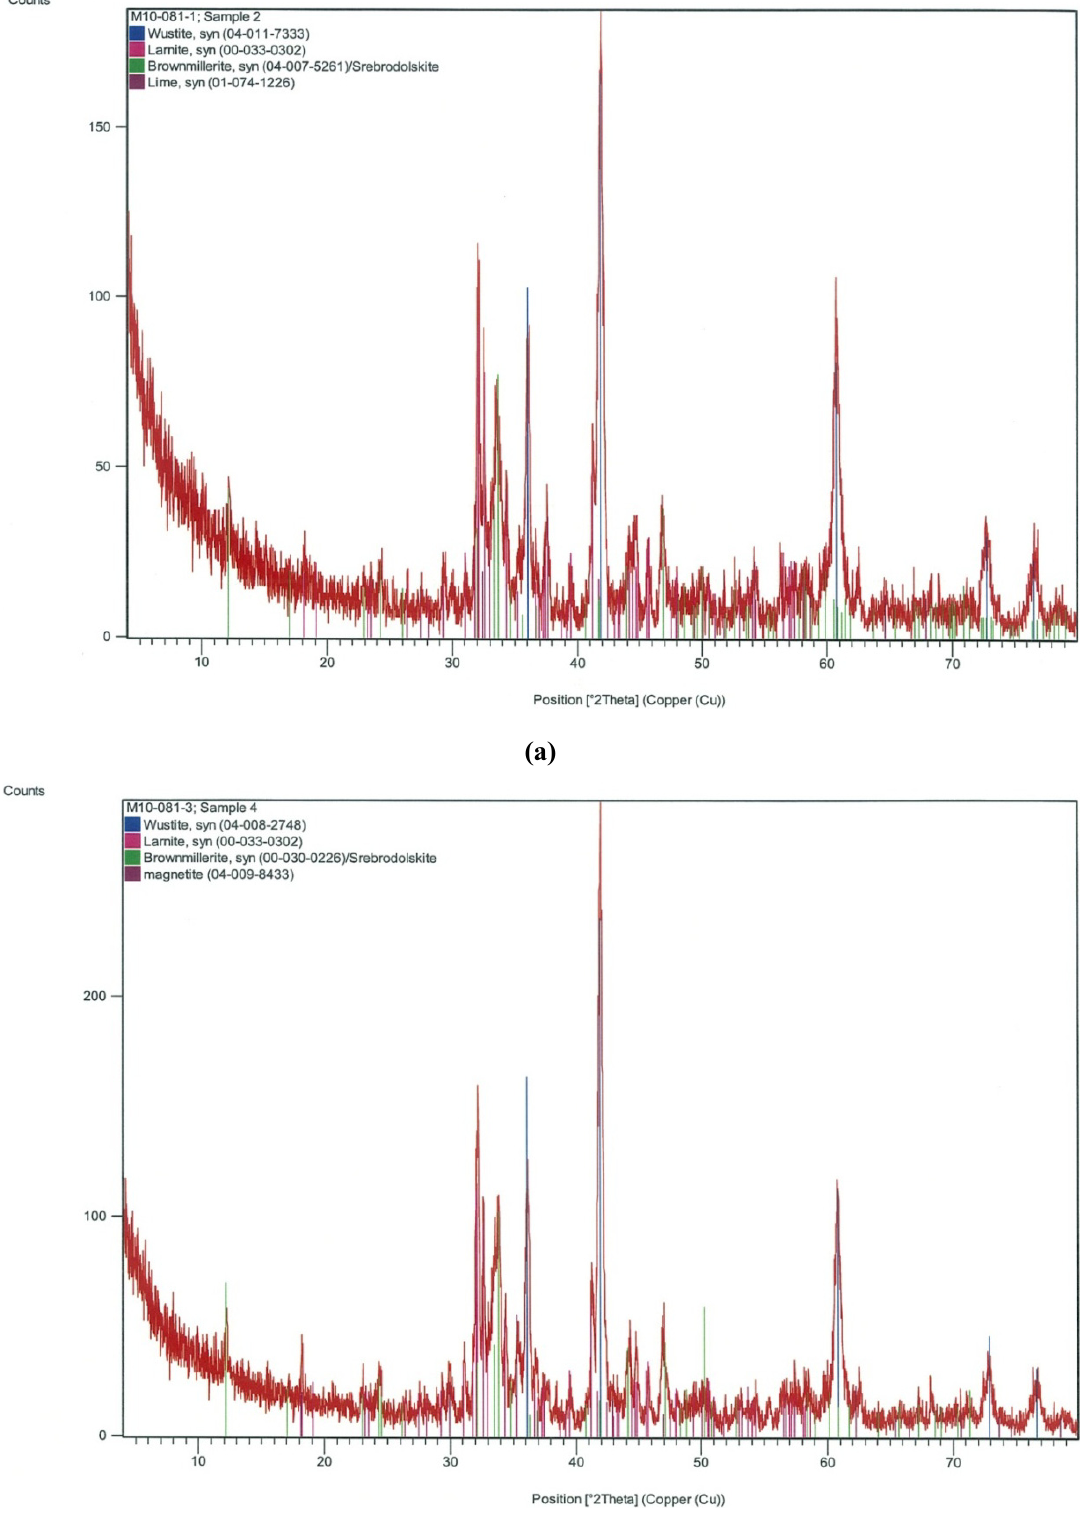
Figure 1. X-ray diffraction pattern of spent slag from ( a ) P-only (P removal: 95%); ( b ) P + Cu (P removal: 68%); ( c ) P + Mix (P removal: